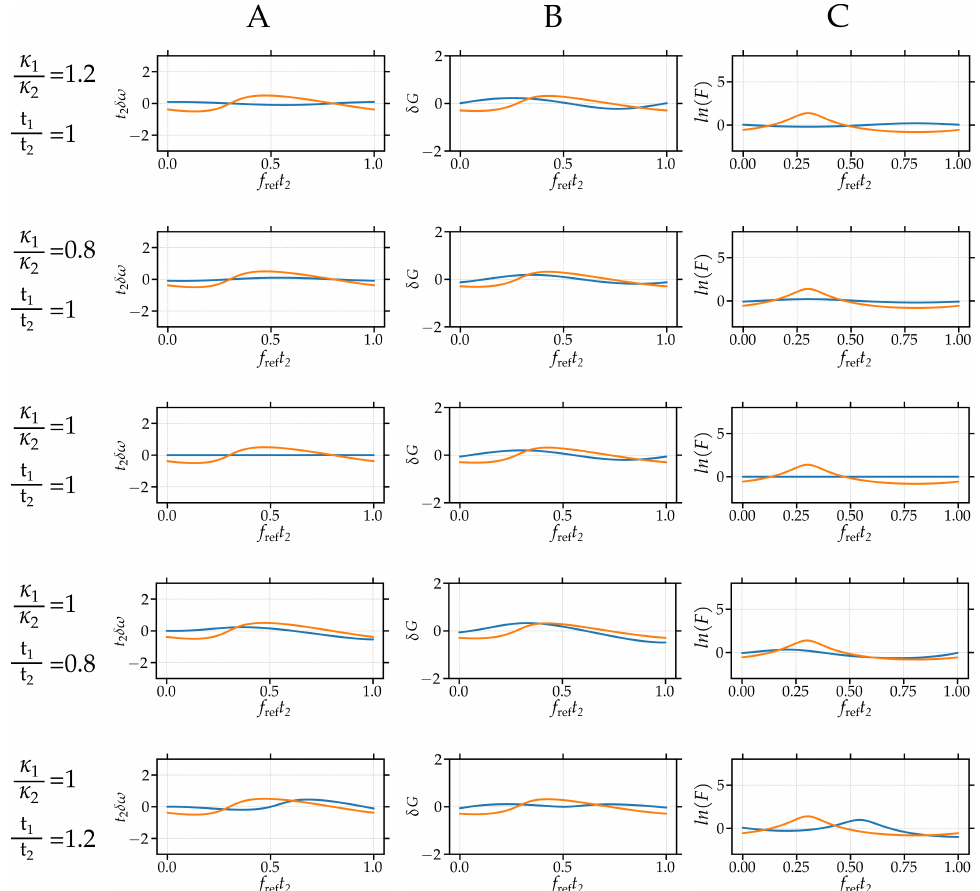
Figure A2. Numerical solutions for C = 0.5 under condition (12) for a ± 20% variation of conditions (8) and (11). Double feedback case shown in blue, single feedback case shown in or- ange. Column ( A ) shows the lasing frequency shift results. Column ( B ) shows the threshold gain shift. Column ( C ) shows the intrinsic linewidth